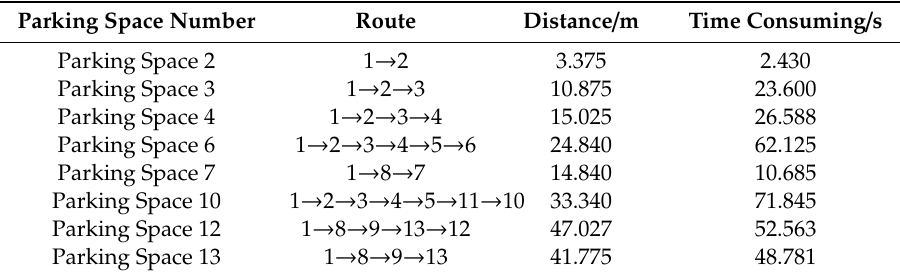
Table 3. Driving route of each parking space under the improved algorithm.